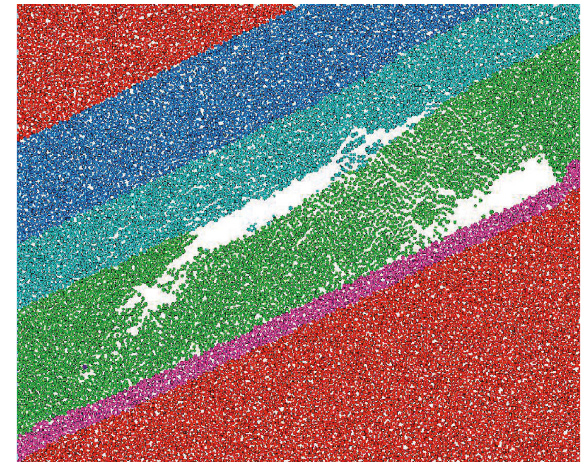
Figure 5: Effect of the coal seam’s dip angle (25 ° ) on coal caving.